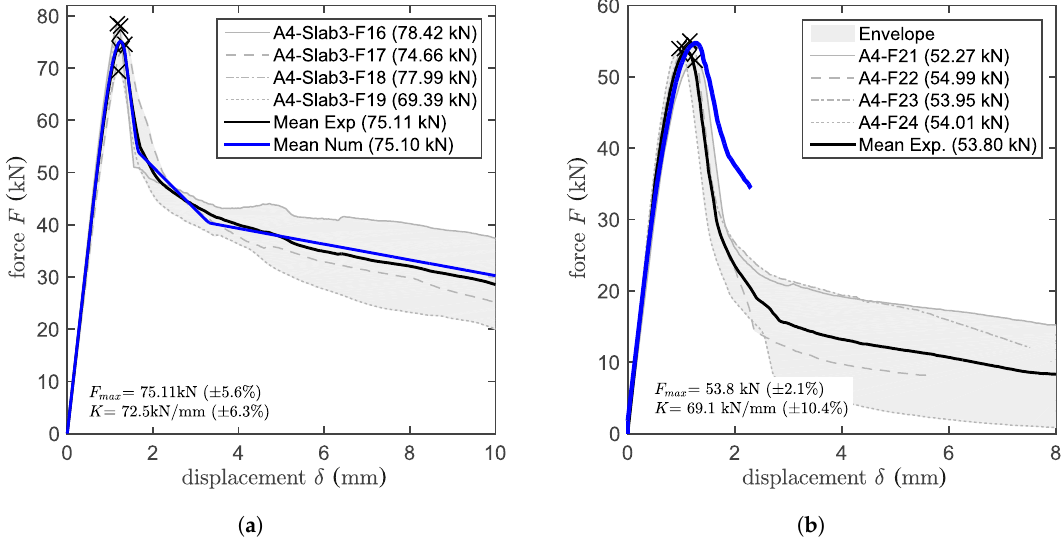
Figure 7. Test results of: ( a ) the confined pull-out test and ( b ) the unconfined pull-out